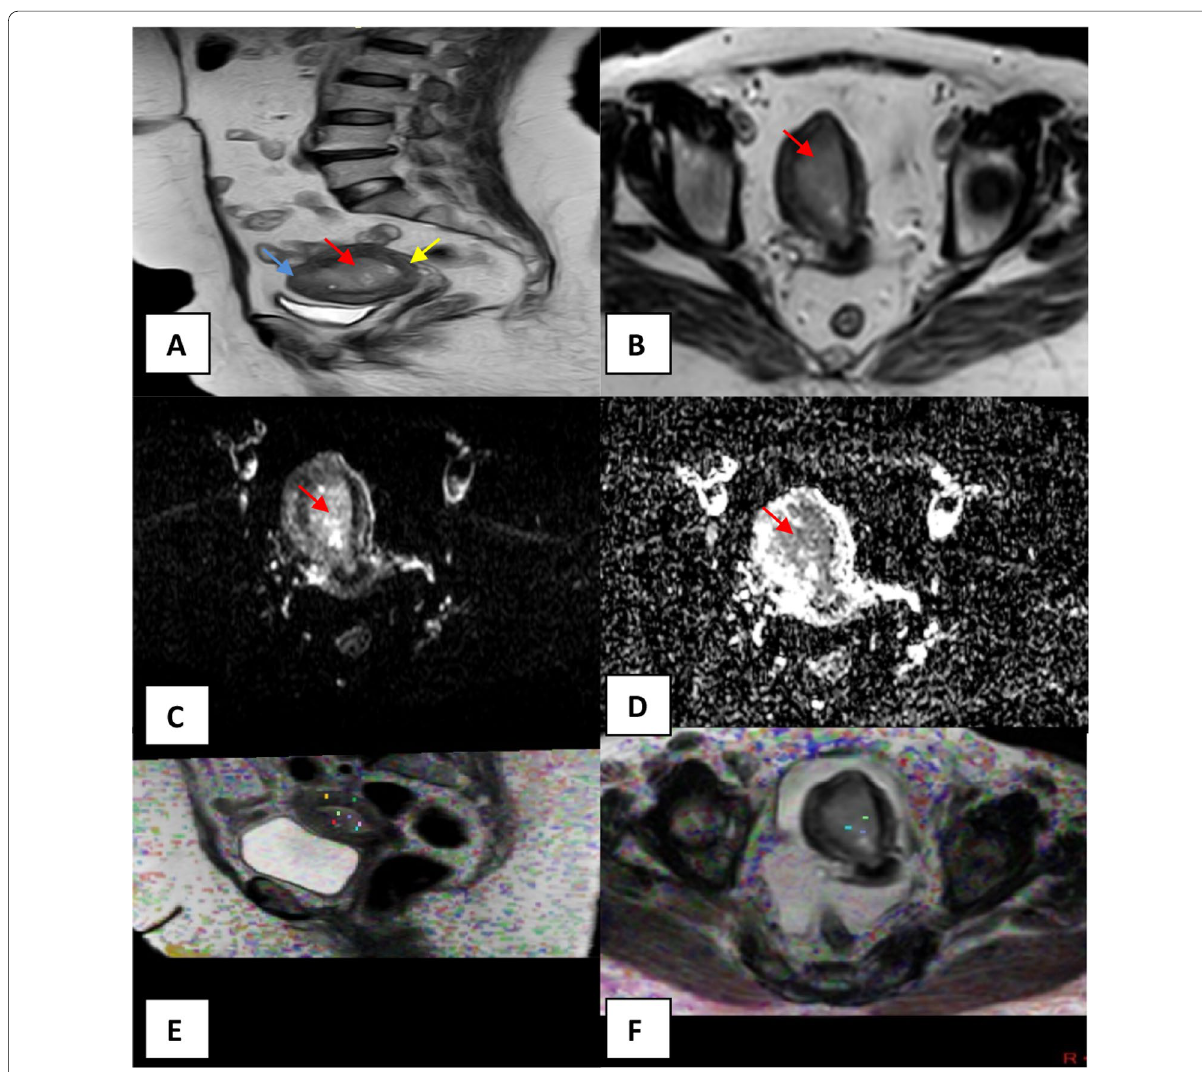
Fig. 7 A 50‑year‑old postmenopausal female presented by abnormal vaginal bleeding. A , B Sagittal and axial T2 WIs irregular endometrial soft‑tissue mass with ill‑defined margins displaying intermediate SI (blue arrow). The mass distends and fills the endometrial cavity with myometrial thinning (red arrow). No cervical extension (yellow arrow). C Axial DWI with b value of 1000 s/mm 2 high SI of the endometrial